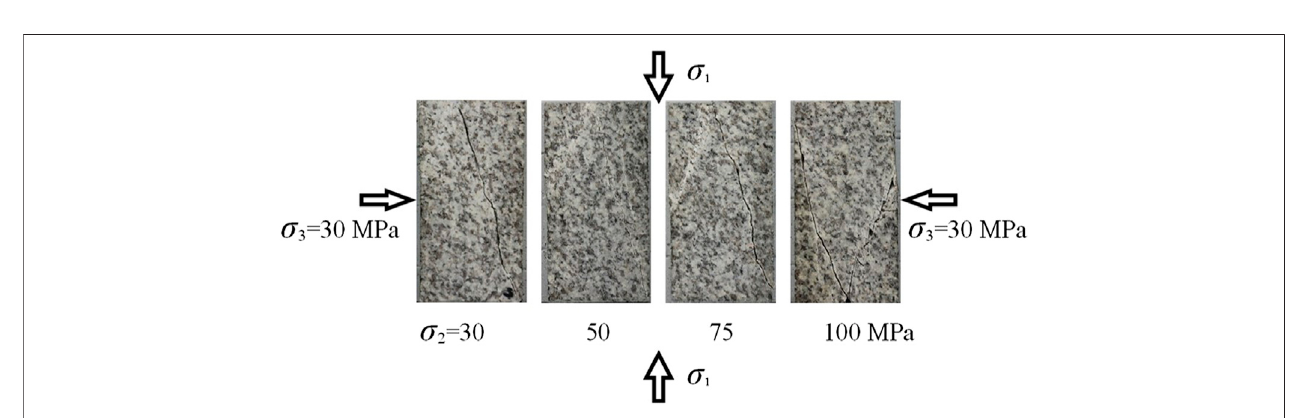
FIGURE 9 | Failure modes of tested granite change with σ 2 when σ 3 is 30